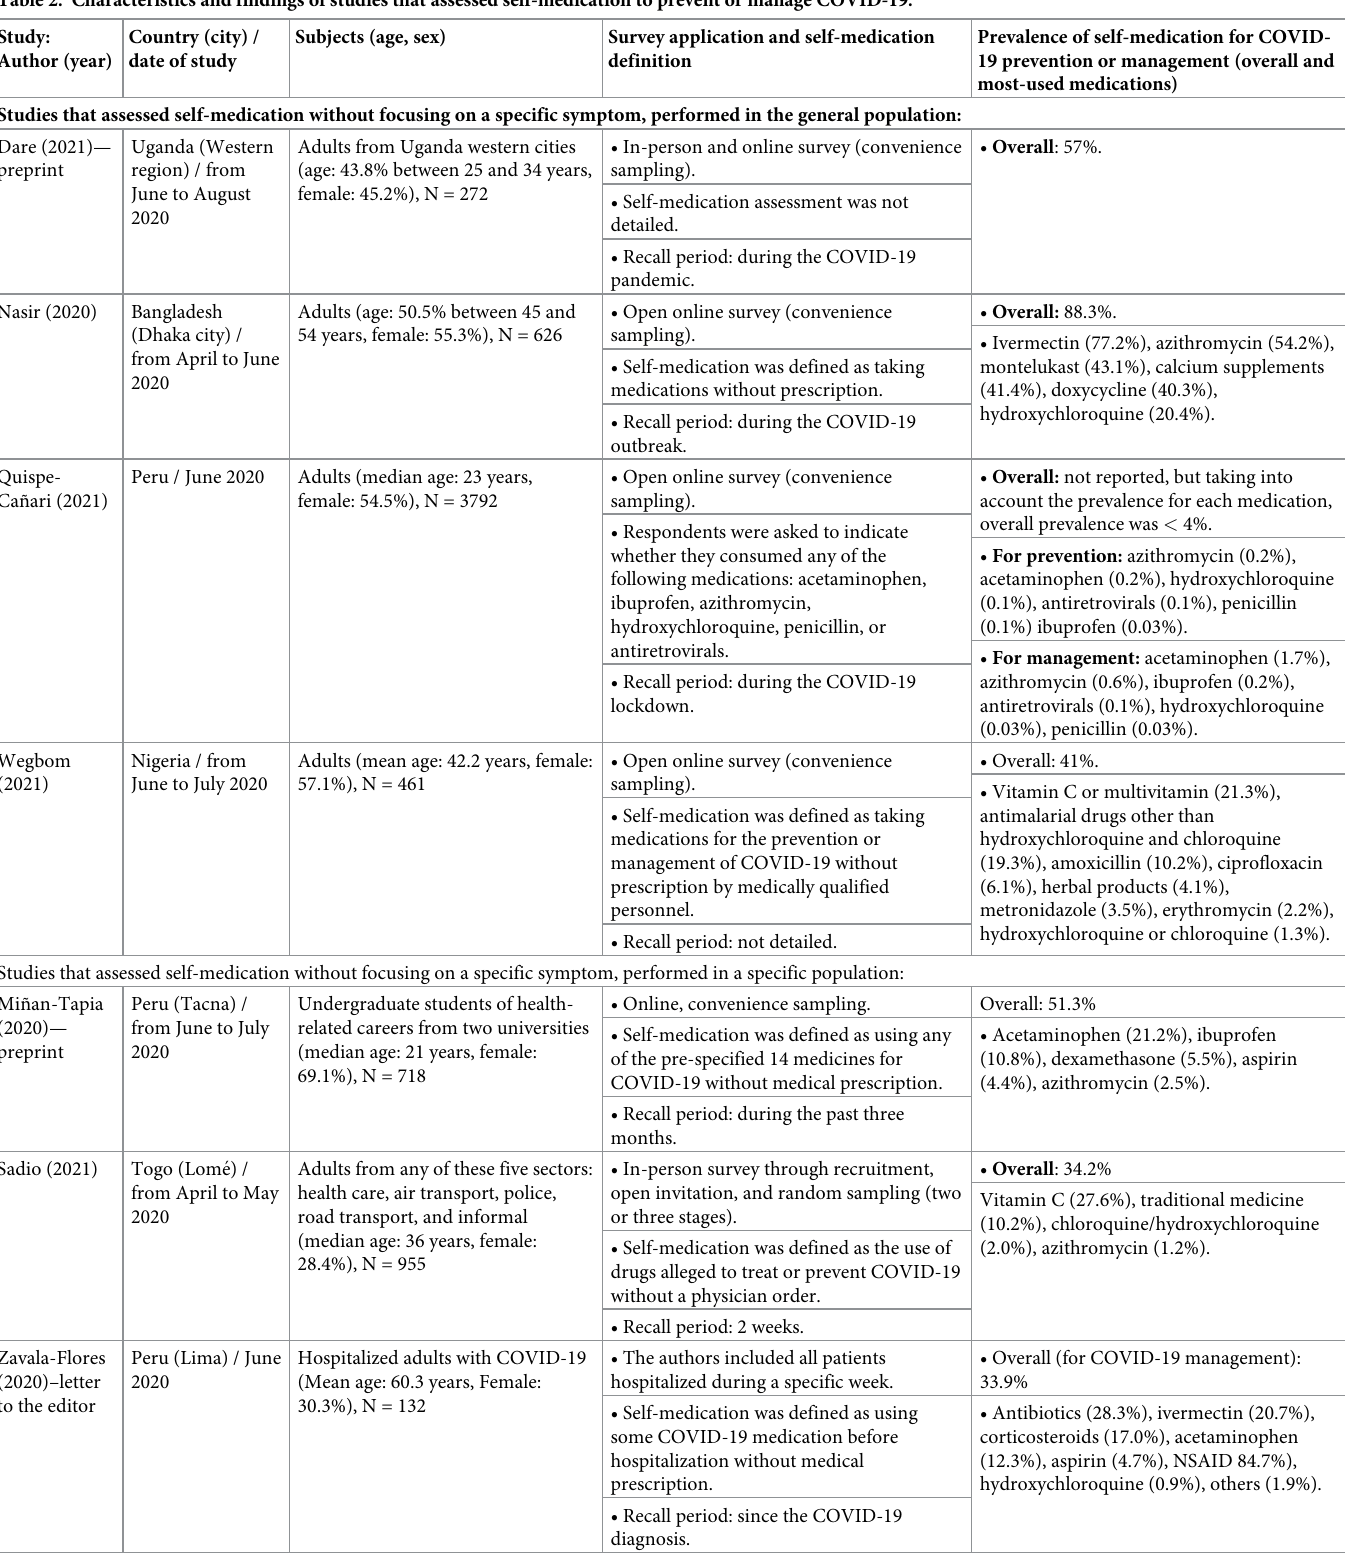
Prevalence of self-medication for COVID- 19 prevention or management (overall and most-used medications)